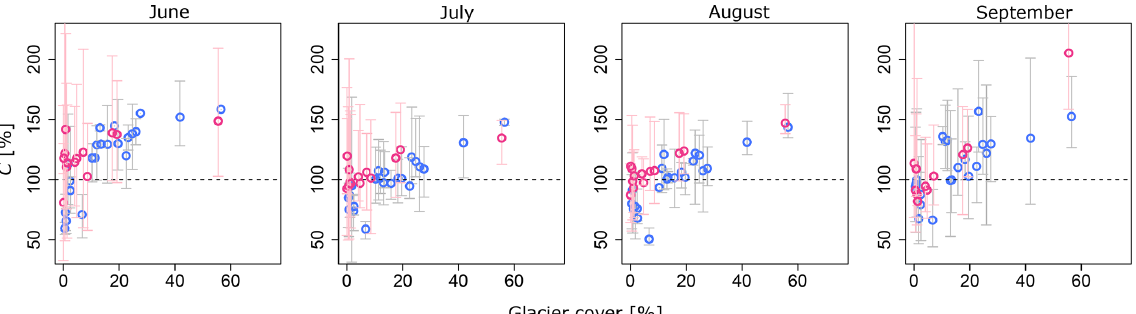
Figure 7. Level of compensation ( C ) during WD events compared among catchments with low average summer rain amounts (July and August) (western Canada; pink) and high average summer rain amounts (European Alps; blue). The colored circles indicate the mean level of compensation, and the pink and gray bars represent the whole range of compensation